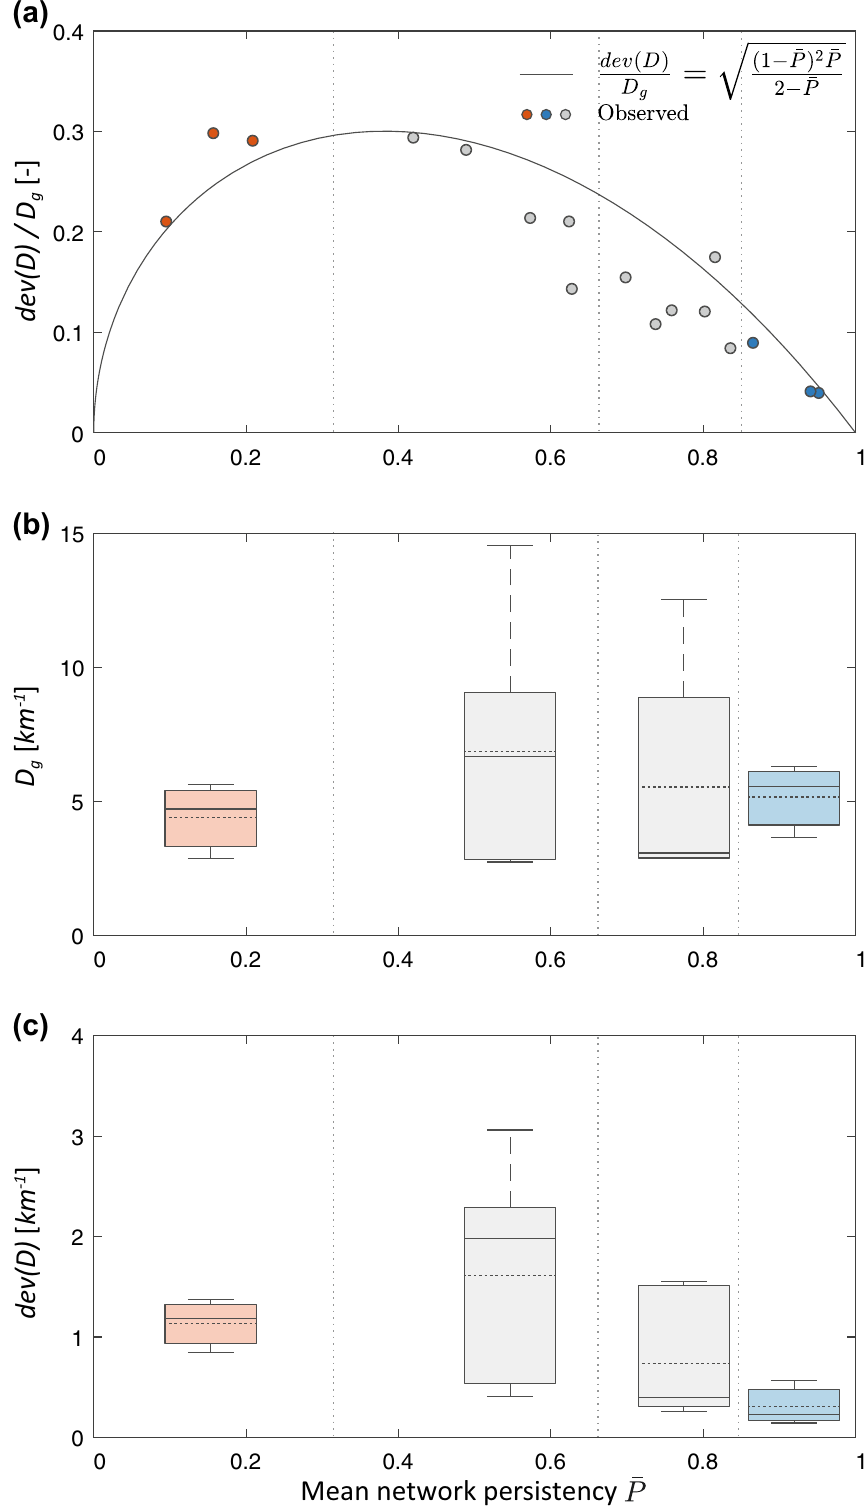
¯ P ; the following statistics are Figure 3. Dependence of key drainage density statistics on the mean network persistency, shown in the three panels: ( a ) the standard deviation of the dynamic drainage density, dev ( D ), scaled to the geomorphic drainage density, D g ; ( b ) the geomorphic drainage density; ( c ) the standard deviation of the active drainage density, that is proportional to the standard deviation of the active length through the contributing area. In panel ( a ) we show a comparison between observed values of Dev ( D )/ D g (dots) and the corresponding theoretical prediction of the analytical model as derived from Eqs. (1) and (4) for all the case studies where active lengths were monitored; in panels ( b , c ) the box-plots represent the first, second and third quartiles of observed data (solid lines) aggregated for different persistency ranges (as indicated by the dashed lines). The average is shown as a dotted line, while the full range is represented by